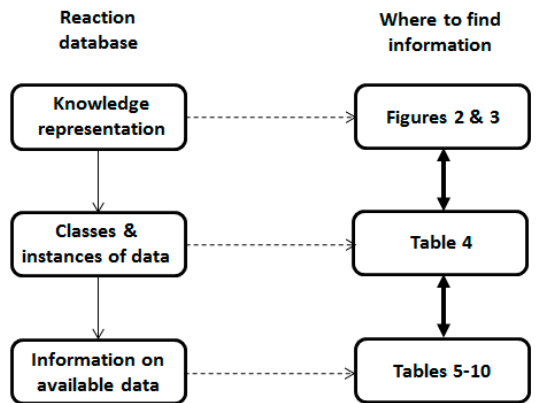
Figure 1. Simplified flow-diagram highlighting the contents of the reaction database. Figures 2 and 3